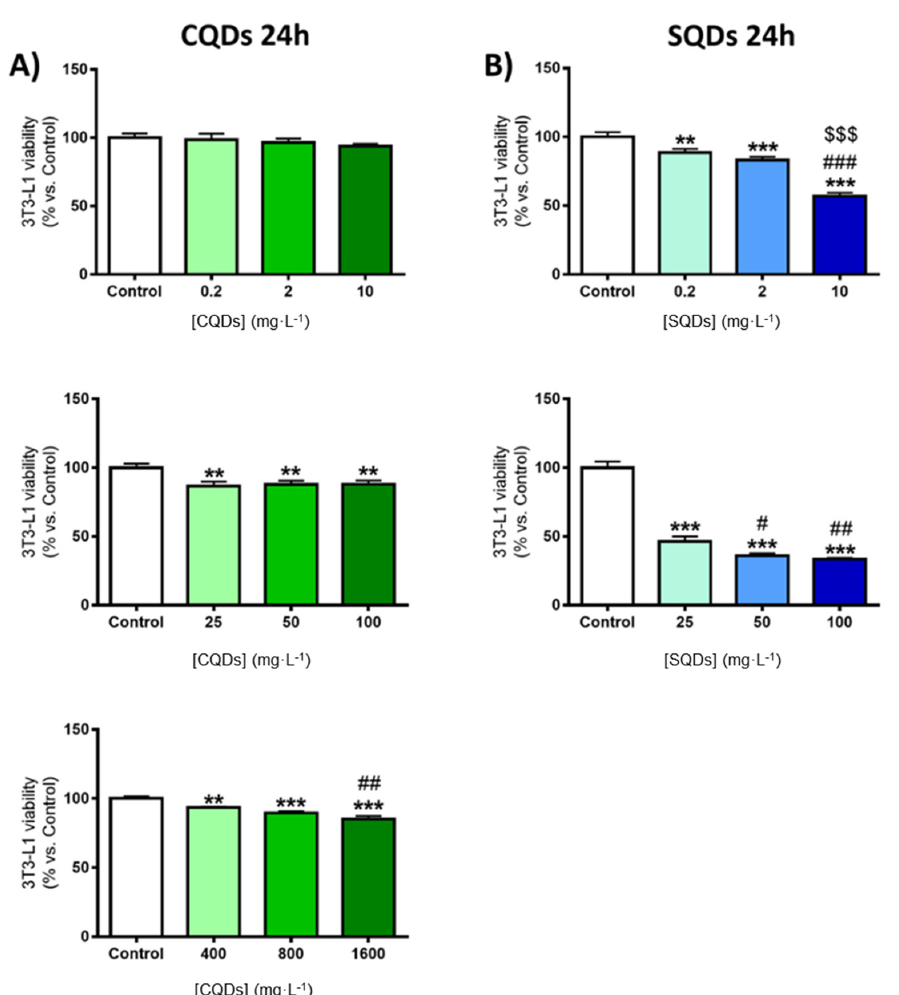
Figure 5. Cell viability data in 3T3-L1 cells cultured in the presence of 10% FBS and exposed to CQDs ( A ) and SQDs ( B ) at concentrations ranging from 0–1600 mg · L − 1 for 24 h. Control cells were cultured in medium (DMEM) alone. Cell viability was measured by the MTT assay. Data (mean ± SEM of at least three independent experiments with three replicate wells per treatment) were analyzed by one-way ANOVA multiple comparison test followed by Fisher’s LSD test. Significant differences are indicated as ** p < 0.01, *** p < 0.001 vs. control; # p < 0.05, ## p < 0.01, and ### p < 0.001 vs. 0.2, 25, or 400 mg·L − 1 , respectively; $$$ p < 0.001 vs. 0.2 mg·L − 1 .